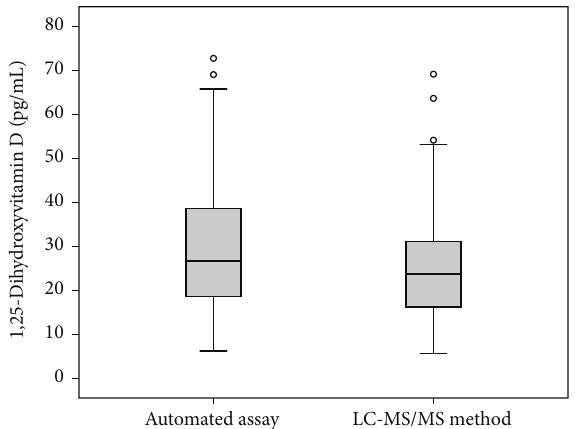
Figure 3: Passing-Bablok regression analysis of the two